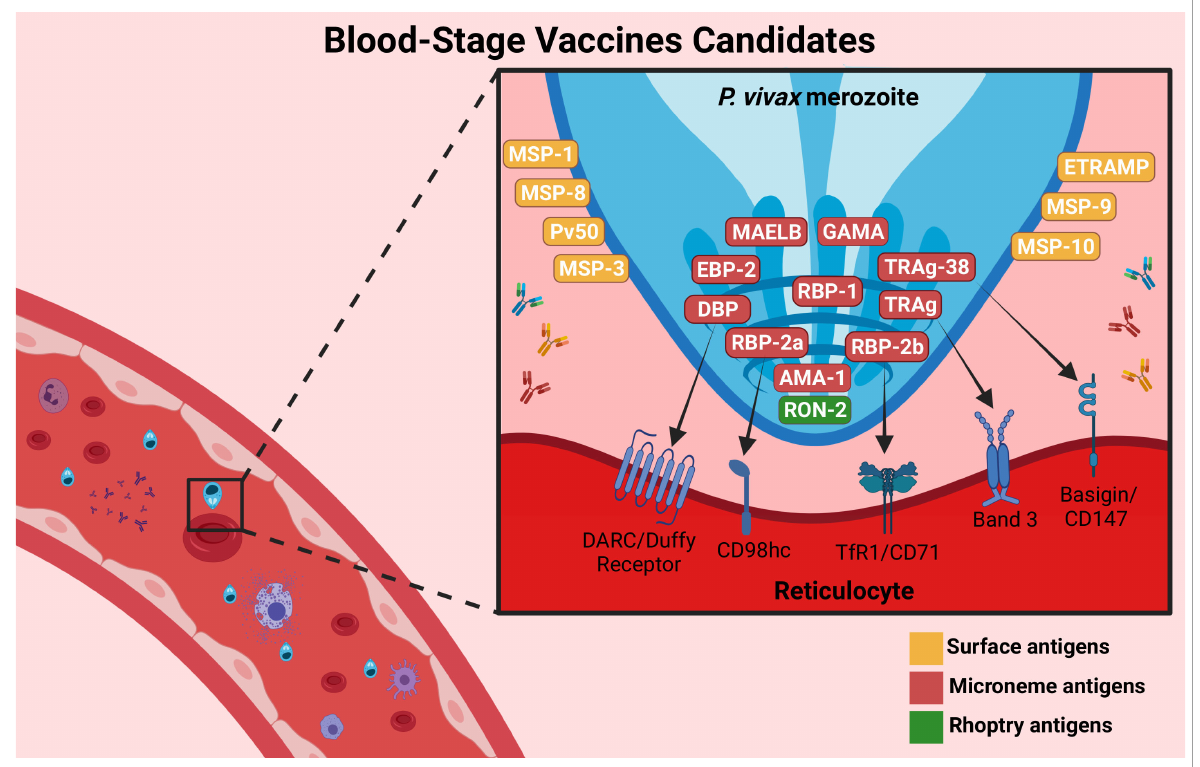
FIGURE 3 Blood-stage vaccine targets. BV candidates are important proteins involved in the invasion of P. vivax into reticulocytes. The main candidates are PvDBP-II (which interacts with the DARC/Duffy receptor), PvRBP-2b (which targets the TfR1/CD78 receptor), PvAMA-1, and the PvMSP family, which are involved in the invasion process. Others were recently described, such as GAMA, PvTRAg (which targets the Band 3 receptor or Basigin/CD147 receptor, such as TRAg-38), MAELB, ETRAMP, RON2 and EBP-2. They are expressed on the surface (yellow), microneme (red) or rhoptry (green) of the parasite. Antibodies against these proteins (represented by “ Y shaped ” on the fi gure) could inhibit the interaction with the reticulocyte receptors, reducing parasitemia and preventing disease symptoms. Created with